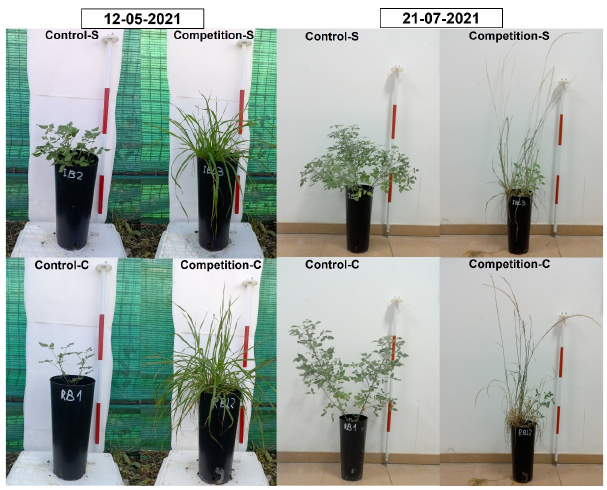
Figure 2. Example of plants under each treatment on two dates, 12 May 2021 and 21 July 2021. Con- trol-S: LANZA ® plants grown without competition in loamy sand soil, Control-C: LANZA ® plants grown without competition in clay soil, Competition-S: LANZA ® plants grown with competition of L. multiflorum in loamy sand soil, Competition-C: LANZA ® plants grown with competition of L. multiflorum in clay soil. Red and white marks on scale bar are 20 cm intervals.